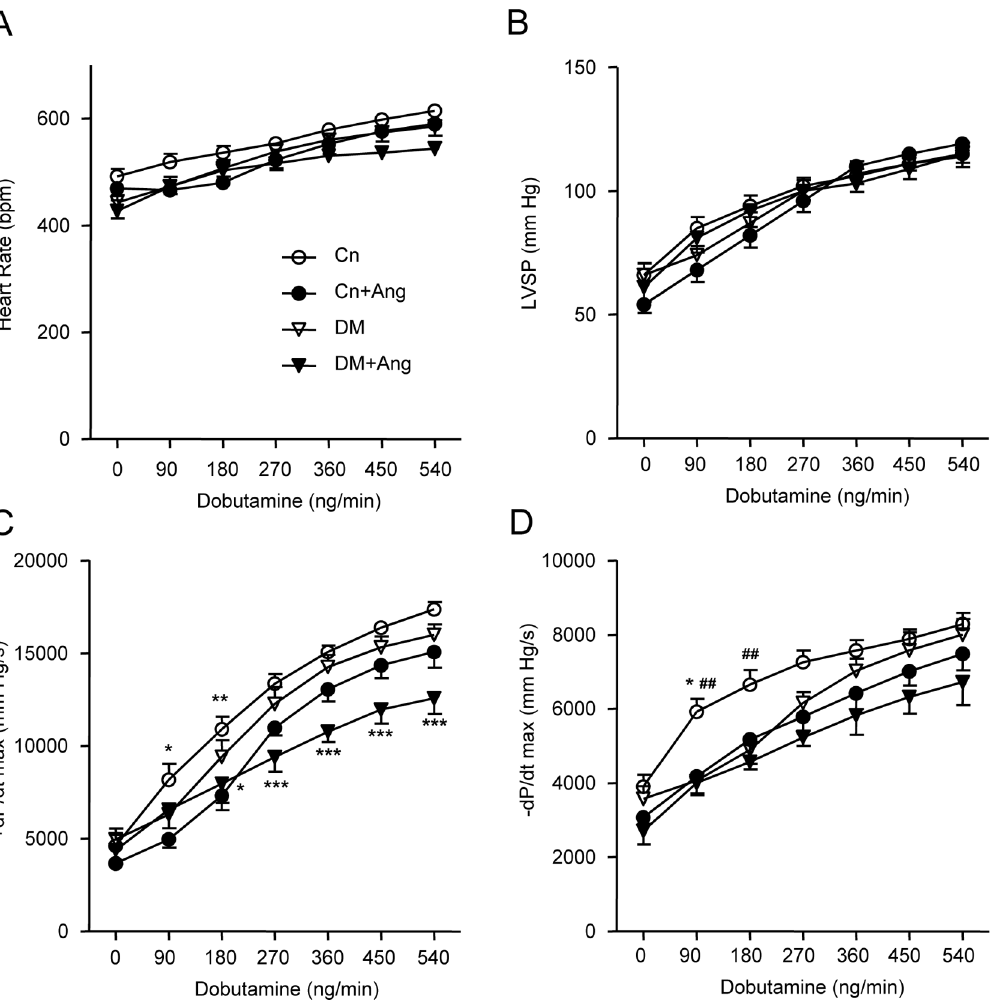
Figure 3. Effect of AngII-induced hypertension on left ventricular function during dobutamine stimulation. Hemodynamic analysis of left ventricular function in non-diabetic (Cn) and diabetic (DM) mice treated with vehicle or AngII (Ang) for 4 weeks (age 18 weeks), at baseline and during dobutamine stimulation. A) heart rate, B) peak systolic left ventricular pressure (LVSP), C) maximal positive pressure development ( + dP/dt max ) and D) maximal negative pressure development (–dP/dt max ). Data are analyzed by two-way ANOVA with Bonferroni post-hoc testing and expressed as mean 6 SEM (n = 7–9 per group). * refers to effect of AngII in non-diabetic and diabetic mice (* P , 0.05, ** P , 0.01, *** P , 0.001) and # refers to effect of diabetes in vehicle-treated and AngII-treated mice ( # P , 0.05, ## P , 0.01, ### P ,